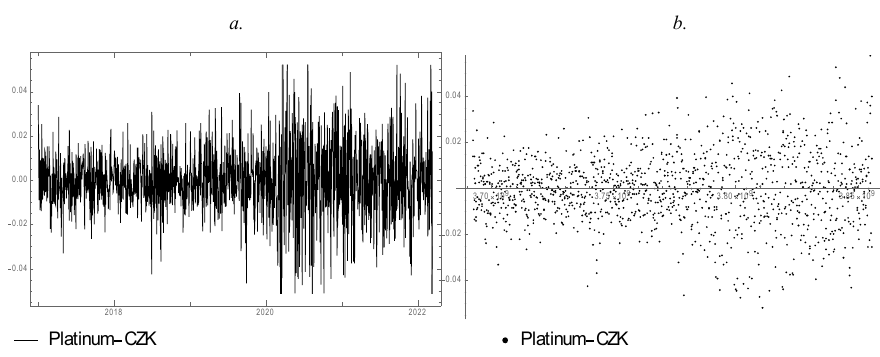
Figure 4. Difference of changes in platinum and CZK prices ( a ) Difference of changes in platinum and CZK prices as a line chart, ( b ) Difference of changes in platinum and CZK prices as a dot chart).